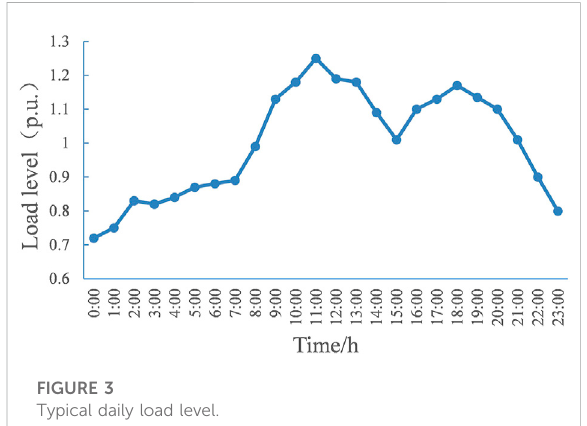
FIGURE 3 Typical daily load level.